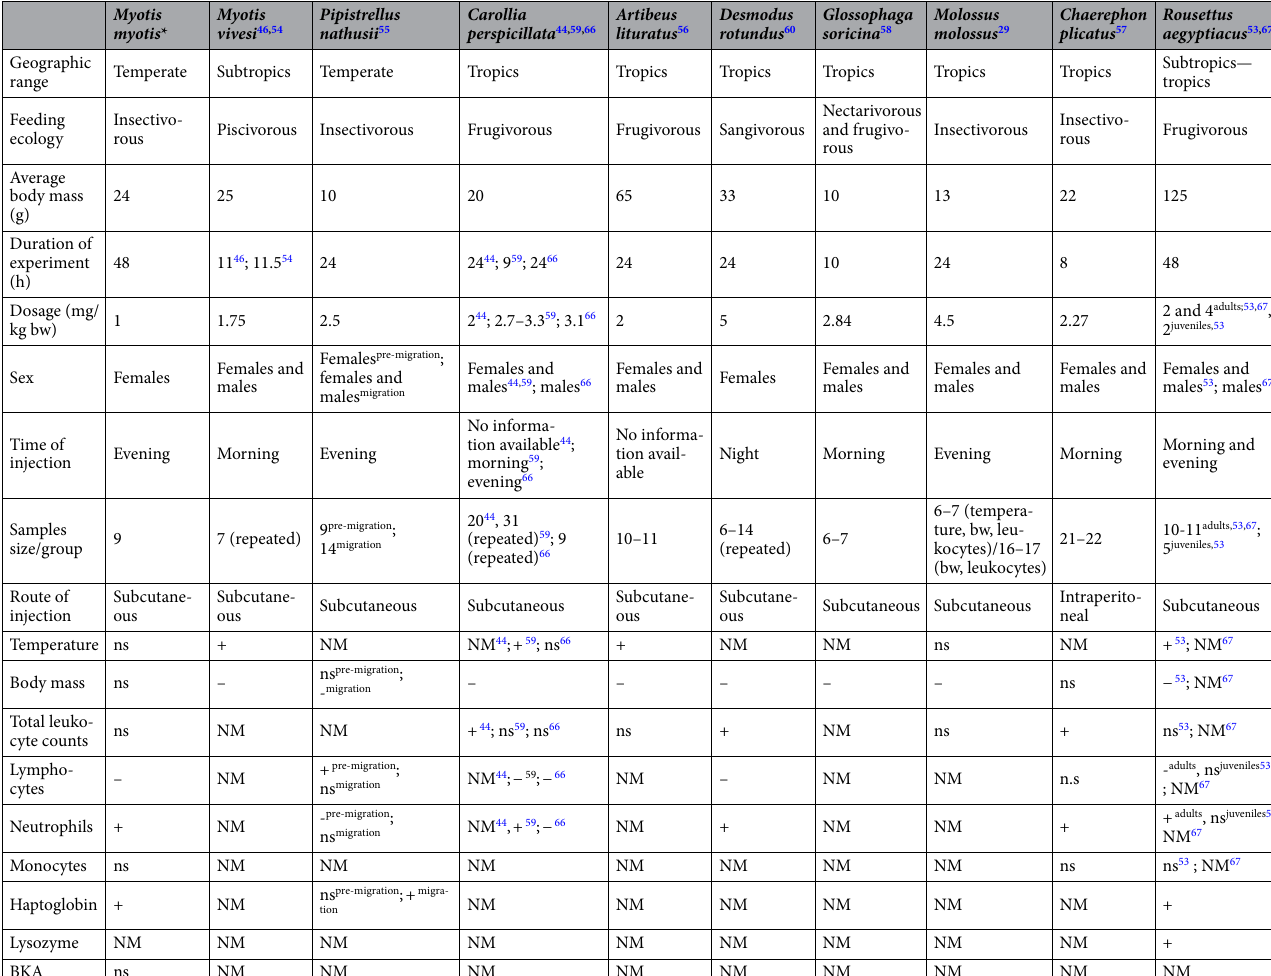
Table 1. Comparative data of LPS challenge studies in various bat species where immunological outcomes were measured. *Current study, ns = non-significant, + = significant increase, − = significant decrease, NM = not measured, bw = body